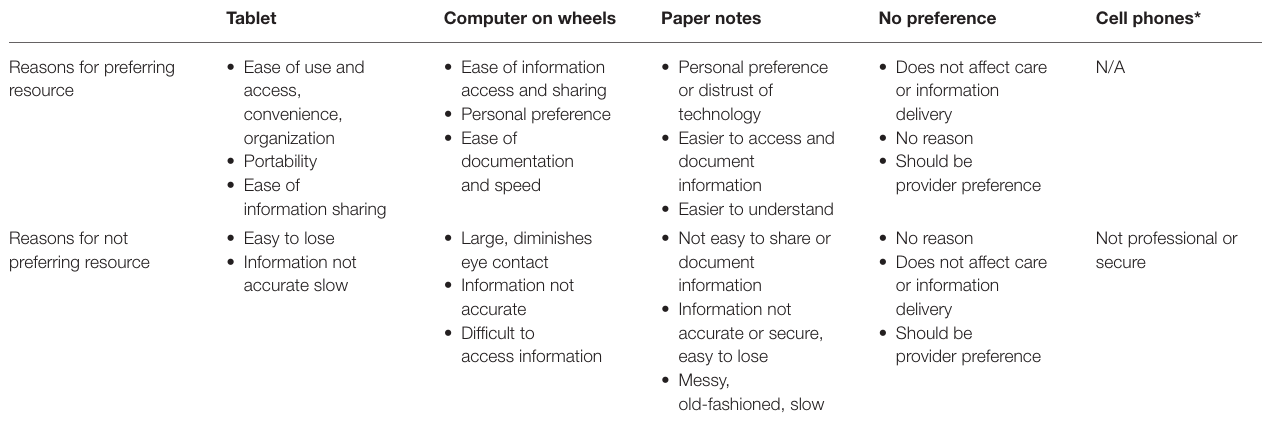
TABLE 3 | Major themes identified related to parent reasoning for preferences for informational resources to be used during family-centered rounds.